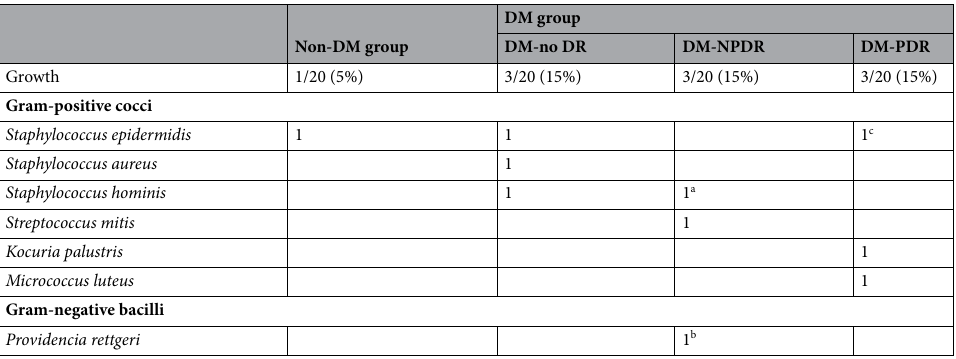
Table 1. Results of bacterial culture in the non-DM and DM groups (with three subgroups of DR staging). DM diabetes mellitus, Non-DM non-diabetes mellitus, No DR no diabetic retinopathy, NPDR non-proliferative diabetic retinopathy, PDR proliferative diabetic retinopathy. a Resistant to benzylpenicillin, erythromycin, clindamycin, fusidic acid. b Resistant to ampicillin, cefazolin, tetracycline. c MRSE: methicillin-resistant Staphylococcus epidermidis